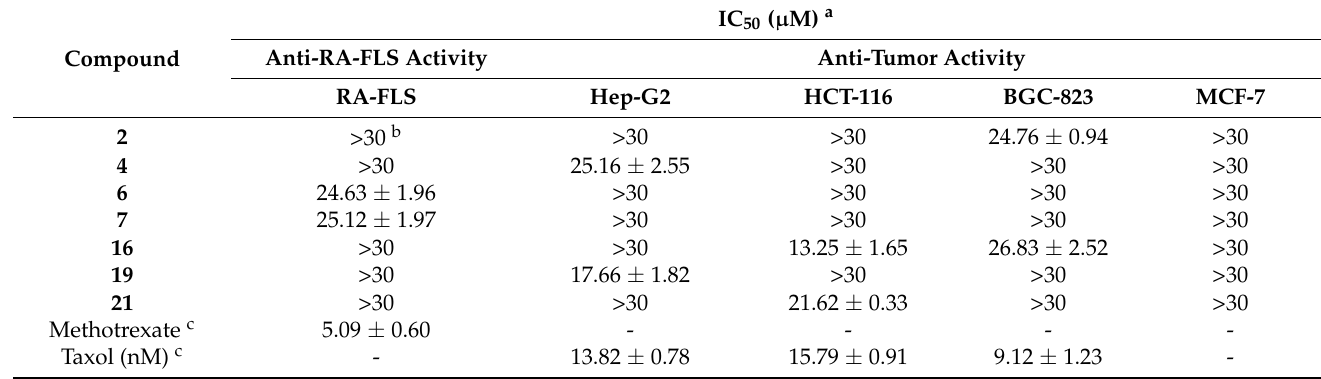
Table 3. Cytotoxic effects of tested compounds on RA-FLS and human cancer cell